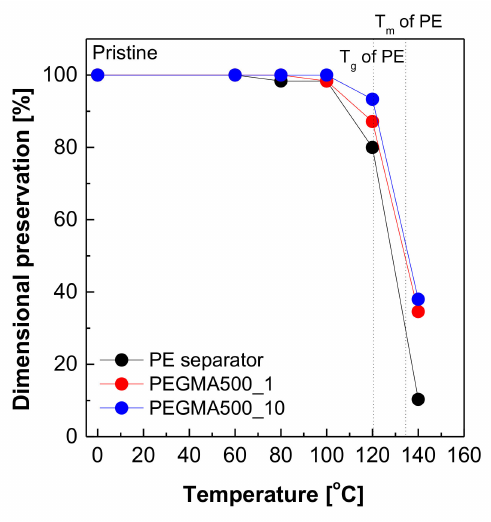
Figure 5. Thermal shrinkage rate of the commercial PE separator and